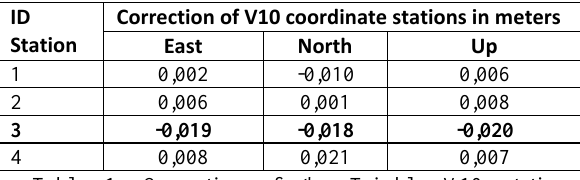
Table 1. Correction of the Trimble V10 station coordinates resulting from TBC Bundle Adjustment